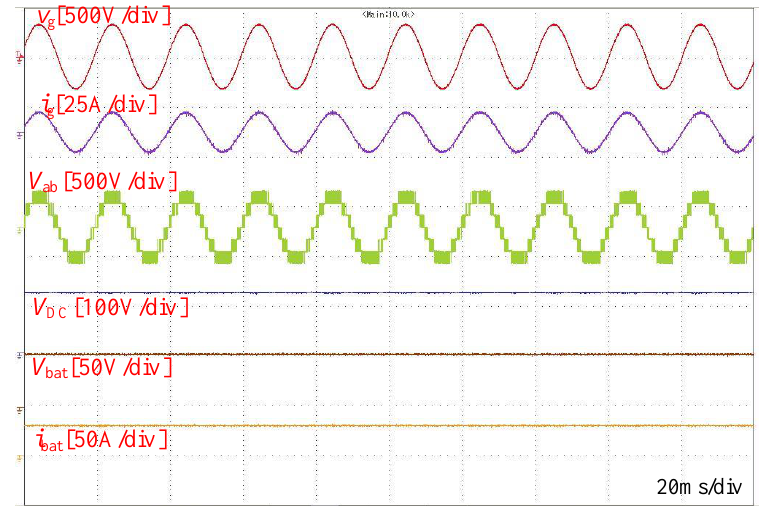
Figure 19. Single phase battery charging with unity power factor.